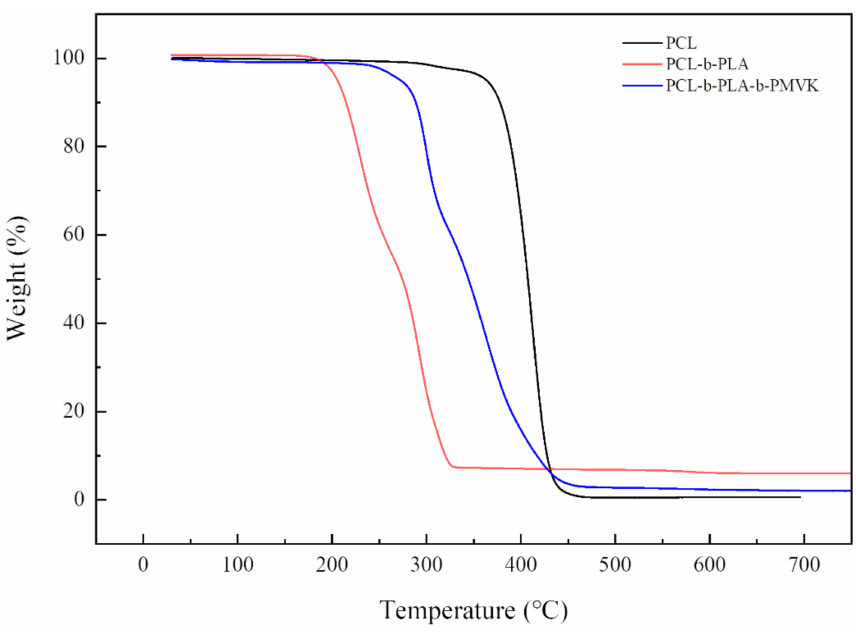
Figure 5. TGA thermogram of PCL, PCL-b-PLA, and the PCL-b-PLA-b-PMVK triblock copolymer.